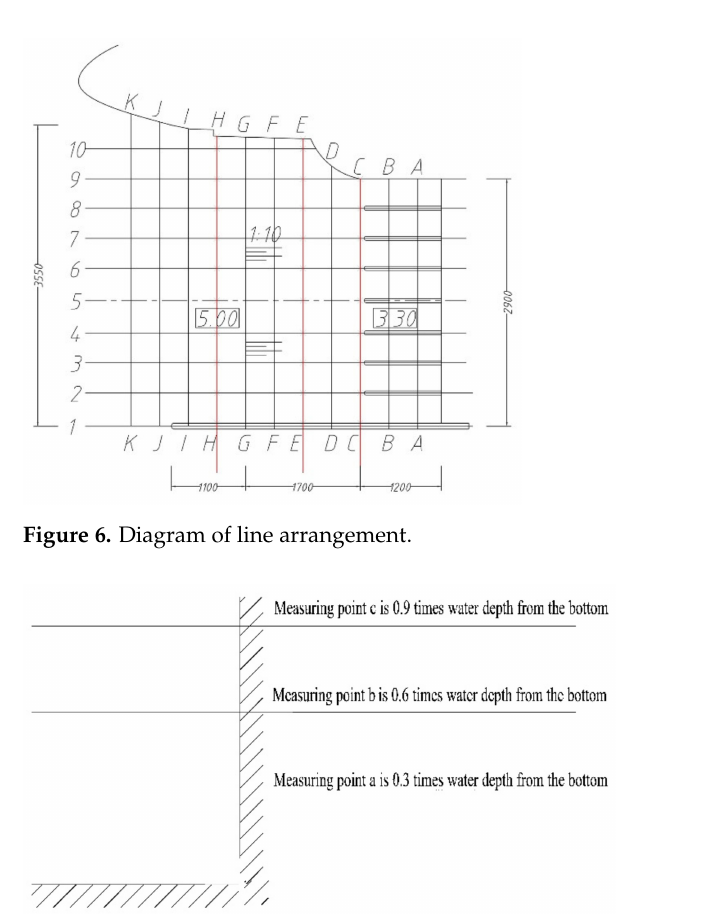
Figure 7. Schematic diagram of measuring point positions.